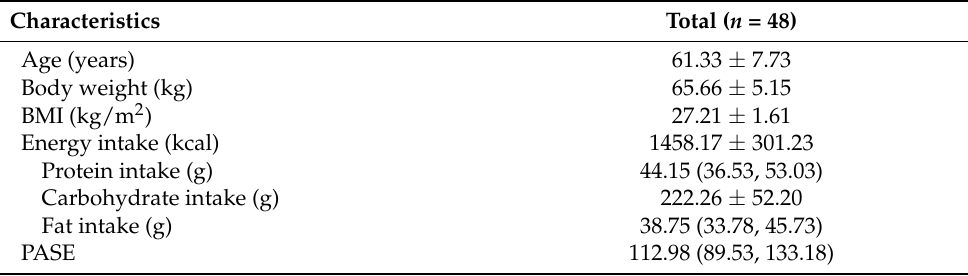
Table 1. The baseline characteristics of study subjects who completed the study.